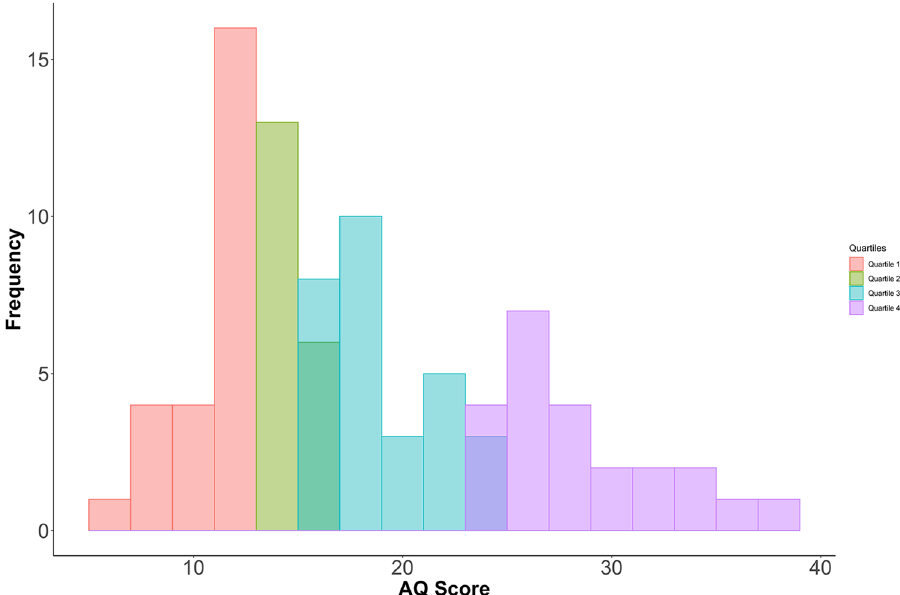
Figure 2. Frequency of AQ scores in the sample. (n = 96). Within the quartiles of interest, Individuals in the Low AQ group fall below a typical population average (N = 25, Mean AQ = 11.36, SD = 1.93 Range 5–13 in Quartile 1 (~ 17, Baron-cohen et al., 2001). Individuals in the High AQ group scored 26 or above are in Quartile 4 (N = 19, Mean = 30.05, SD = 3.96, Range 26–39). Previous studies have reported 80% of individuals diagnosed with autism also score 26 or above 59 .